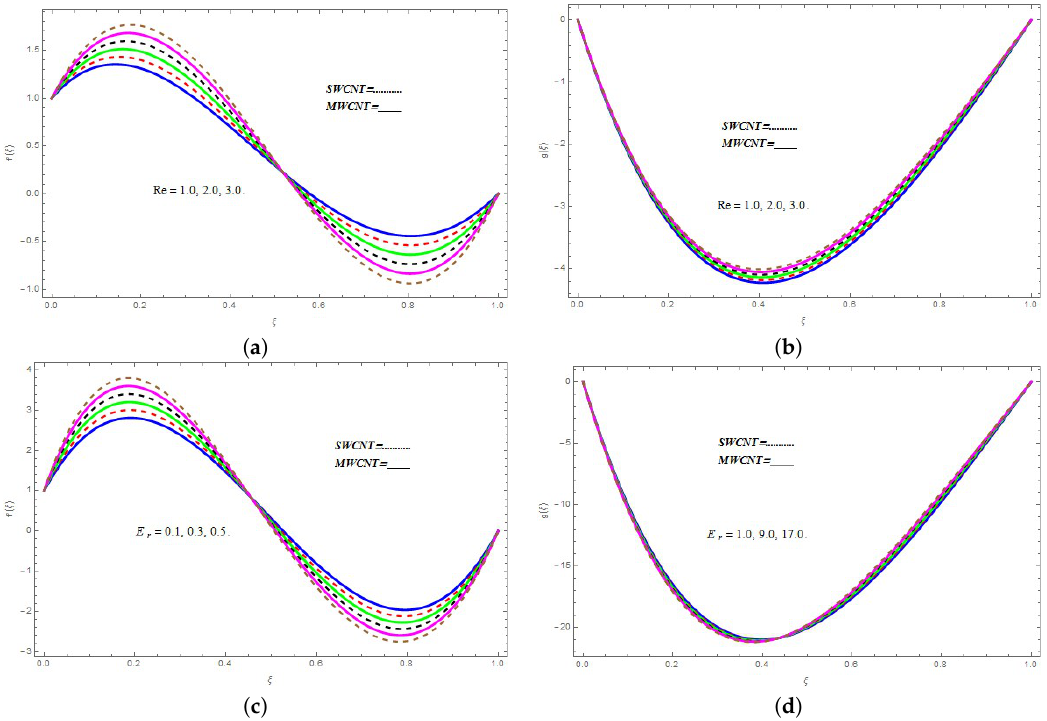
Figure 3. ( a ) Impact of Re on f (cid:48) ( ξ ) ; ( b ) Impact of Re on g ( ξ ) ; ( c ) Impact of E r on f (cid:48) ( ξ ) ; ( d ) Impact of E r on g ( ξ ) (cid:48) ( ξ ) as well as g ( ξ ) is displayed by Figure 4a,b. Within the restricted The influence of N r on both f region, the escalating values of N r first result in a decrease and, after that, cause a growing